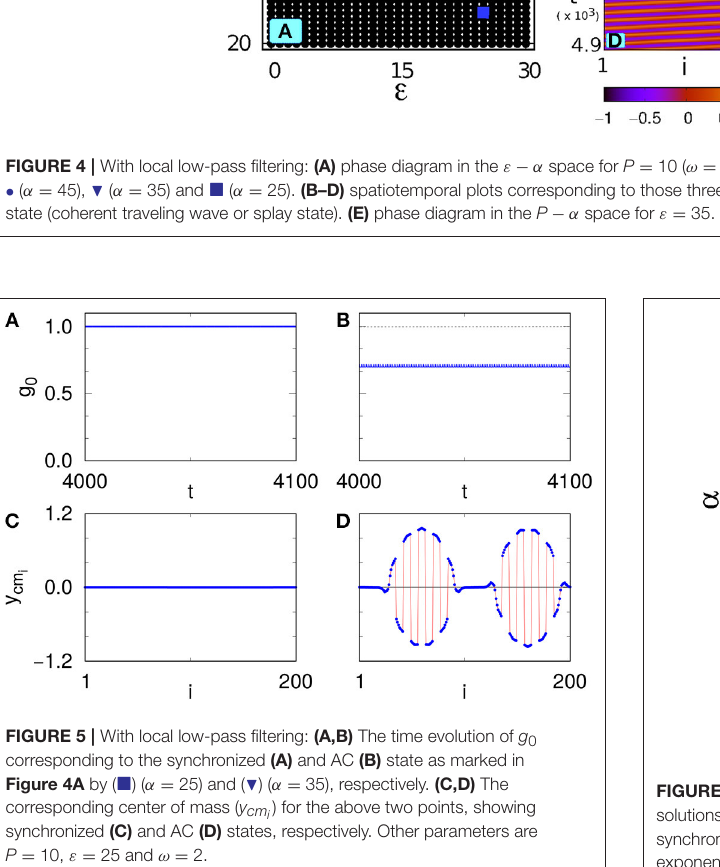
α space based on the Floquet exponent. For the − 10, ω 2, N = = =